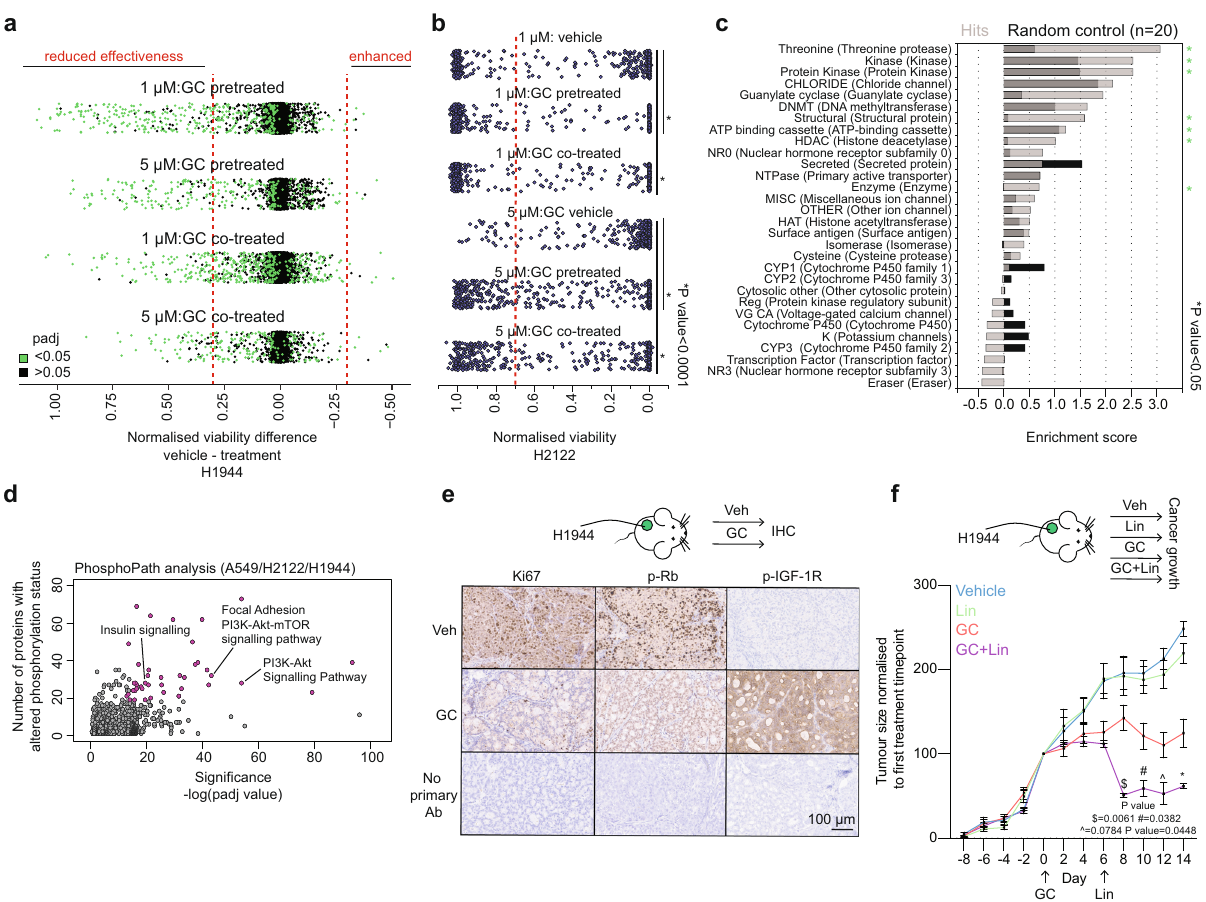
Fig. 2 Cell dormancy phenotype is accompanied by drug tolerance and viability maintenance via growth factor signalling activation. a Scatter plot showing viability differences of vehicle and glucocorticoid pre-treated or co-treated screen arms with either 1 μ M and 5 μ M of the screening drugs. Compounds having signi fi cant differential viability are depicted in green ( P adj < 0.05). Adjusted P values ( P adj) were determined by two-sided t test with multiple testing correction (Benjamini – Hochberg method). b Normalised viability of H2122 cell lines in response to compounds found to diminish viability (<0.7) of vehicle arm of H1944 cell lines in the fi rst screen at 5 μ M concentration. P values were determined by two-sided Welch ’ s t test. c Compound Set Enrichment Analysis data computed using CSgator software of drugs with reduced ef fi cacy upon GC treatment. Random controls of the same size were generated to compute background enrichment ( n = 20). P values (FDR-adjusted) were determined by CSgator software. d PhosphoPath pathway analysis of phosphoproteomics data depicting signalling changes in glucocorticoid-treated cells (A549, H2122 and H1944) ( n = 3). P values were determined by PhosphoPath software. e Representative images showing immunohistochemical stainings of xenograft cancer samples obtained after treatment of NOD- SCID- γ mice with either vehicle (Veh) or glucocorticoids (GC) ( n = 4). Primary antibody was omitted as staining control. Scale bar, 100 μ m. f Normalised tumour growth in xenograft models of H1944 cells in NOD-SCID- γ mice treated with either vehicle (Veh = blue), linsitinib (Lin = green), glucocorticoids (GC = red), or combination (GC + Lin = purple). Arrows indicate when treatment was started. Mean values ± SEM depicted (Dexa + Lin n = 4, Dexa n = 6, Veh n = 5, Lin n = 6 animals). P values were determined by mixed-model ANOVA (Tukey ’ s multiple comparison (Supplementary Fig. 3d). The modest response to GC/IGF-1R inhibitor combination in H2122 may be explained by the pre- existing dependency of this cell line on IGF-1R signalling in absence of GCs, as suggested by the data available on The Cancer Dependency Map portal 24 (Supplementary Fig. 3e). In conjunc- tion with induced vulnerability to IGF-1R inhibitors, phospho- pathway analysis of the three cell lines revealed signi fi cant changes in the protein phosphorylation status of insulin signalling (including IGF-1R protein) and the related downstream pathways 25,26 , con fi rming the implied increase in their activity upon GR activation (Fig. 2d).